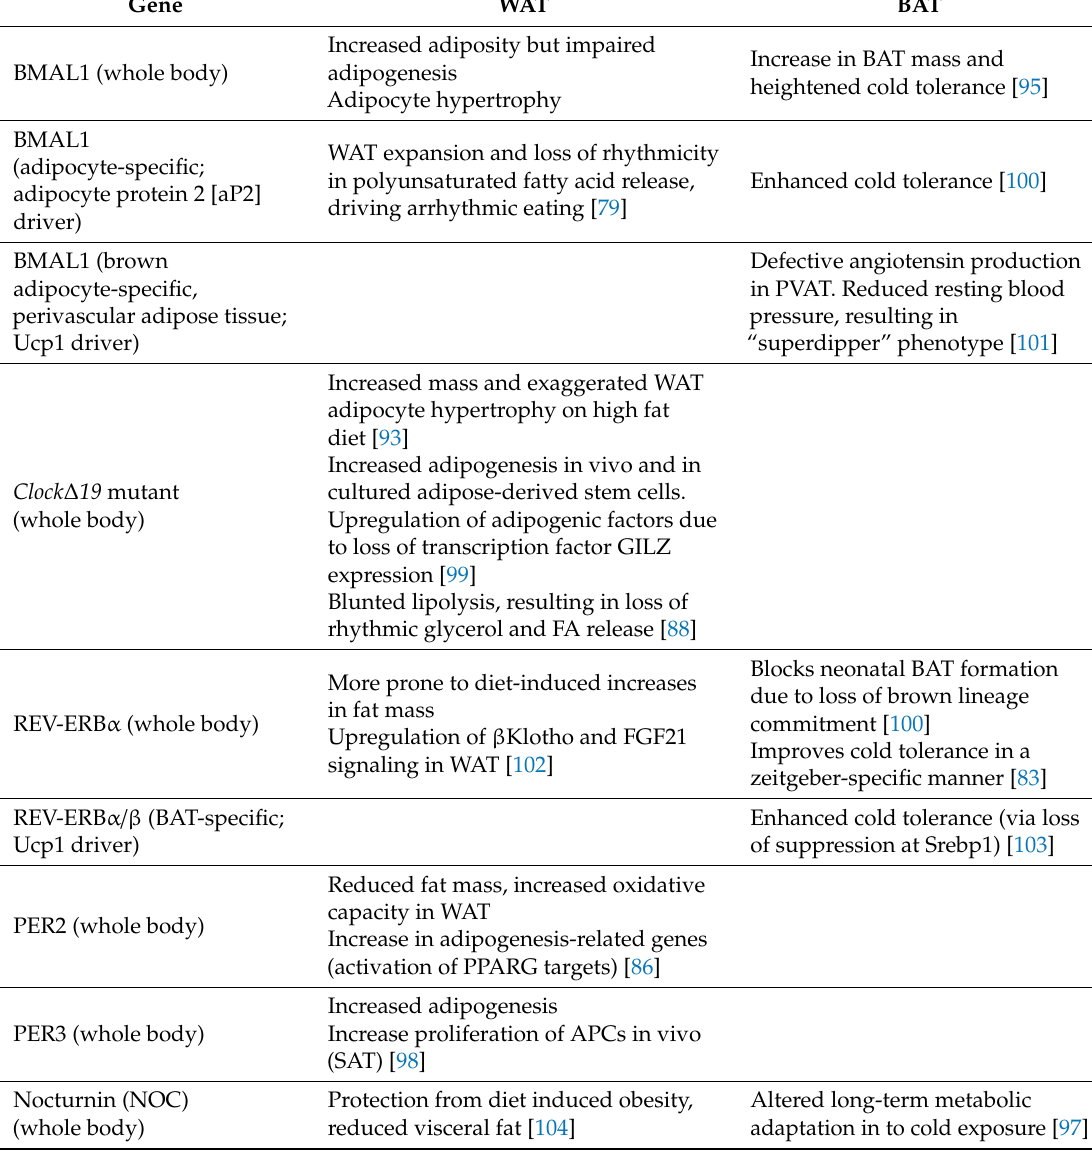
Table 1. E ff ects of tissue-specific vs. whole body circadian gene knockouts on adipose